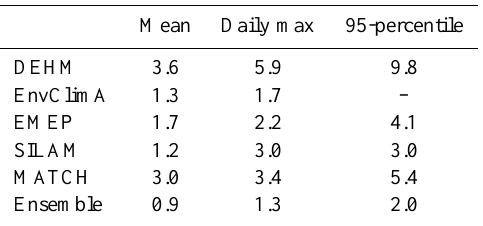
Table 4. Maximum positive changes in mean, daily max and 95- percentile of summer surface O 3 . Mean Daily max 95-percentile DEHM 3.6 5.9 9.8